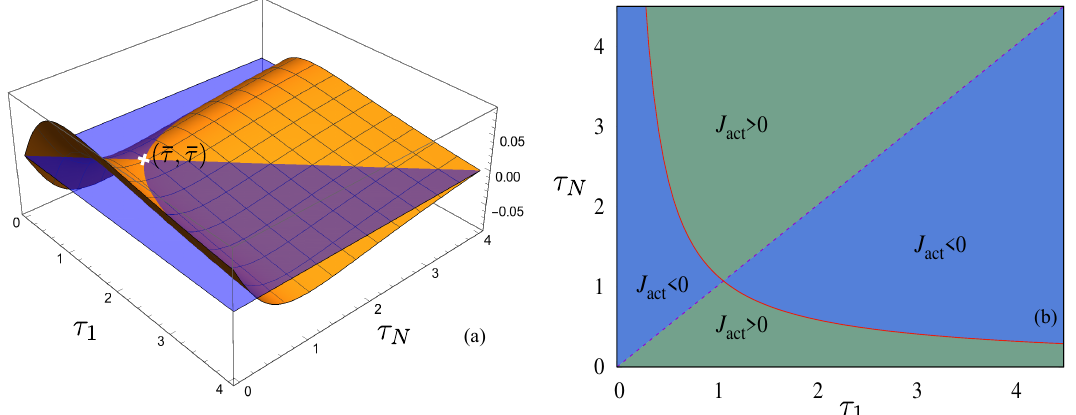
) plane: the meshed orange Figure 4: (a) Three dimensional plot of J on the ( τ , τ N act 1 surface denotes J given by Eq. (5) in the main text, while the un-meshed, semi- act = 0. The curves formed by intersection transparent blue surface corresponds to J act of these two surfaces give the locus of the zeros of the active current, the intersection = τ = ¯ τ , which clearly is a saddle point of of these two curves are denoted by τ N 1 > 0 in the region above the blue surface, while J < 0 in the region below J . J act act act the blue surface. (b) Two dimensional projection of (a) showing phase diagram of ) plane—: The light blue (green) shade indicates the region where J in the ( τ , τ N act 1 the active current is negative (positive). The continuous red curve shows τ ∗ as a N = τ function of τ whereas the dashed curve indicates the line τ N 1 1